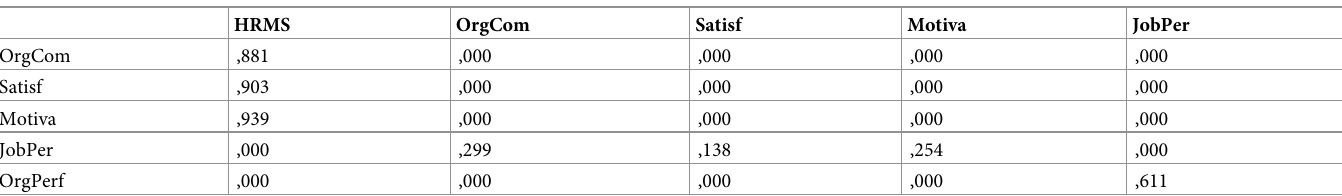
Table 7. Standardized direct effects among variables within the